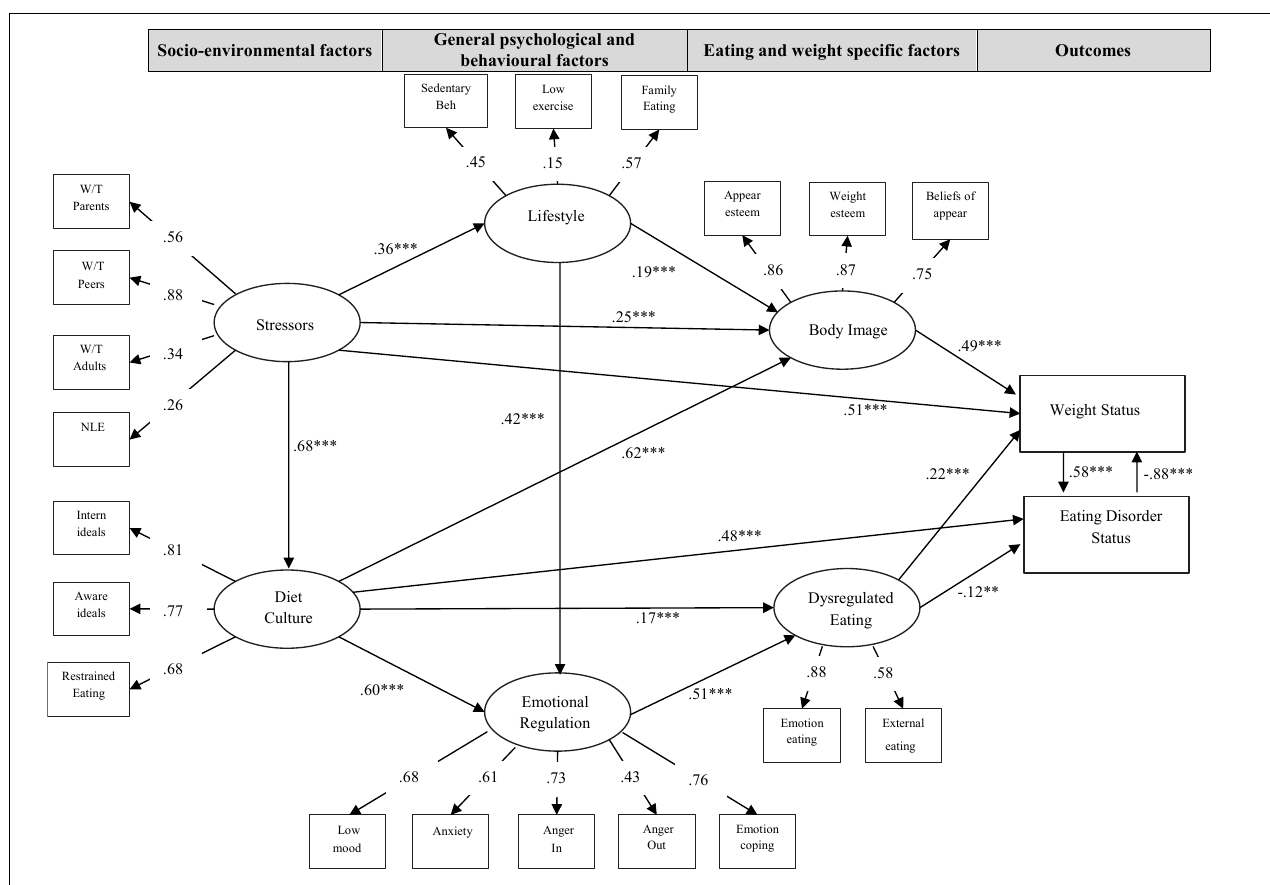
FIGURE 2 | Final structural model of standardized path coefficients. ** p < 0.01, *** p < 0.001; W/T Parents: McKnight Risk Factor Survey (MRFS) – Weight-based teasing from parents subscale; W/T Peers: McKnight Risk Factor Survey (MRFS) – Weight-based teasing from peers subscale; W/T Adults: McKnight Risk